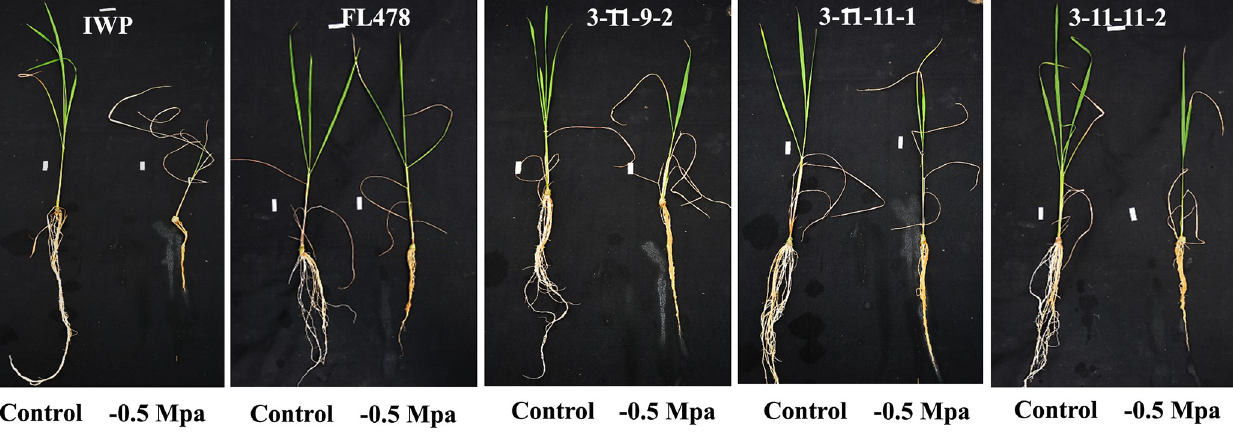
Fig 7. Screening for drought tolerance using